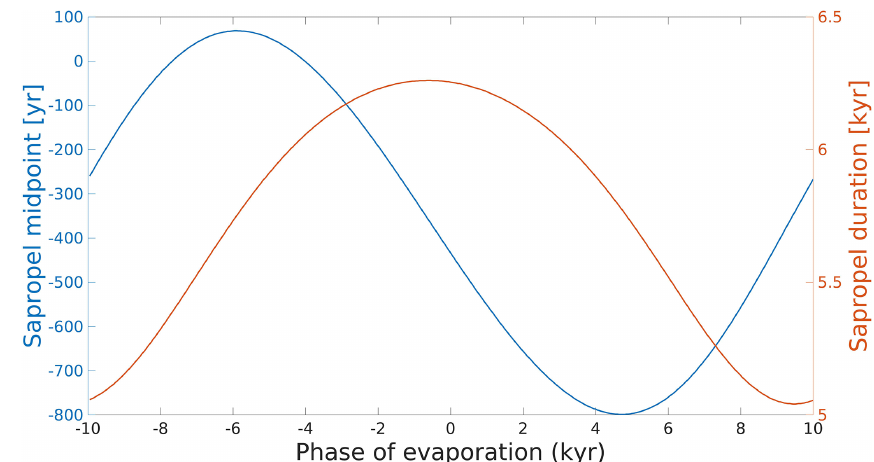
Figure 7. Sapropel duration (right axis) and the timing of the midpoint relative to the precession minimum (on the left axis) as a function of the phase of evaporation. Apart from the phase of evaporation, the model forcing is the same as the run in Sect. 3.2.